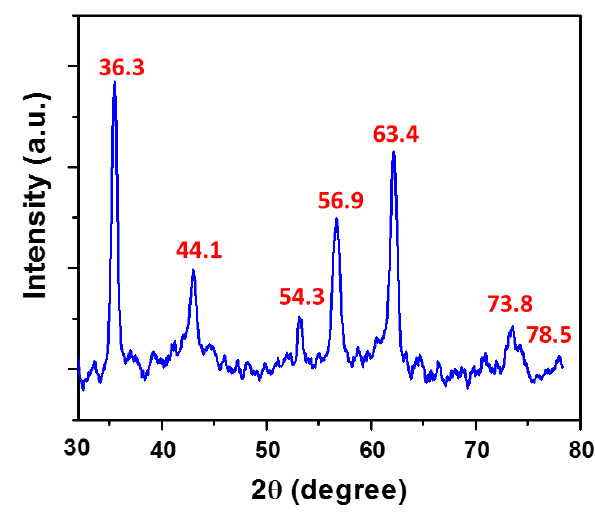
Figure 1. X-ray diffraction spectrum of APD-AgNPs-Hg 2+ complex.